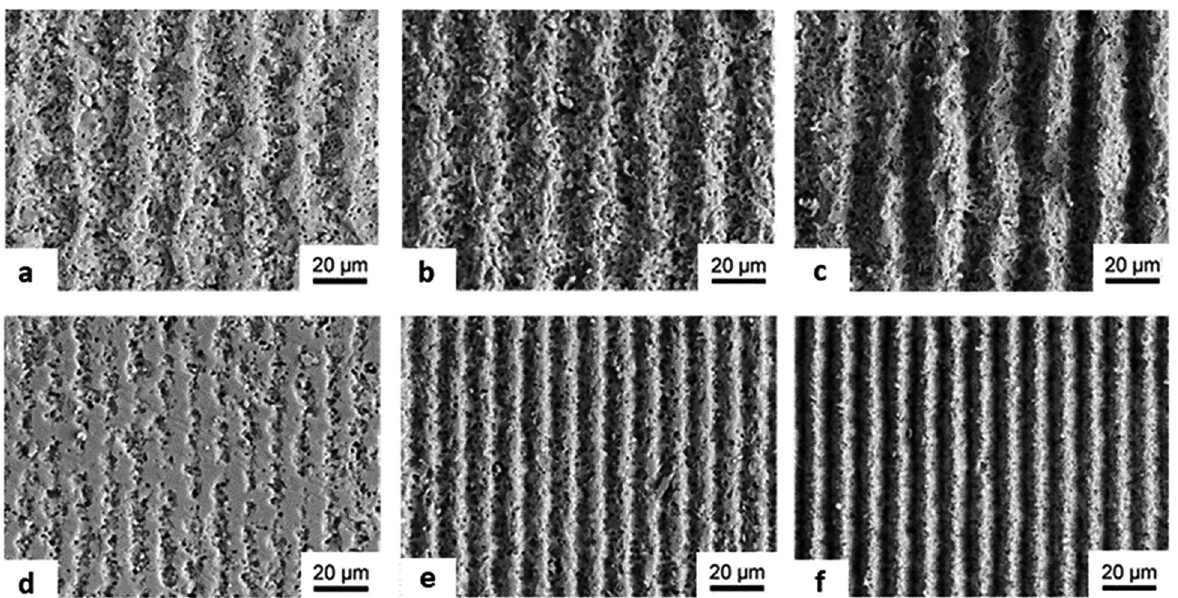
Figure 14: SEM-micrographs of periodic line-like patterns fabricated on hydroxyapatite with 355 nm laser radiation, 20 µm period and 1.2Jcm − 2 oflaser fl uencewith(a)one,(b)10and(c)50pulsesandwith266radiation,10µmperiod, fl uenceof0.6Jcm − 2 with(d)one,(e)10and (f) 50 pulses. Figures adapted from ref. [134] (© 2011 Elsevier